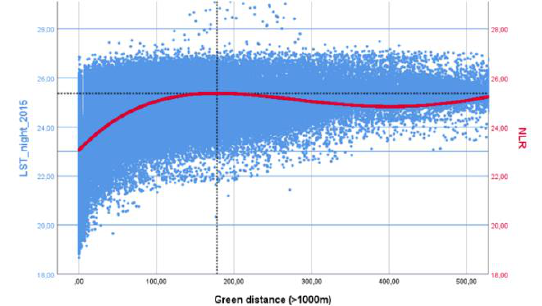
Figure 8 . Temperature vs. Distance to Green Areas Figure 8 shows the land surface temperature in relation to the distance to the green areas of the urbanized land in the Barcelona Metropolitan Area. The adjustment by means of non-linear regression (NLR) of a fourth-degree polynomial model, helps